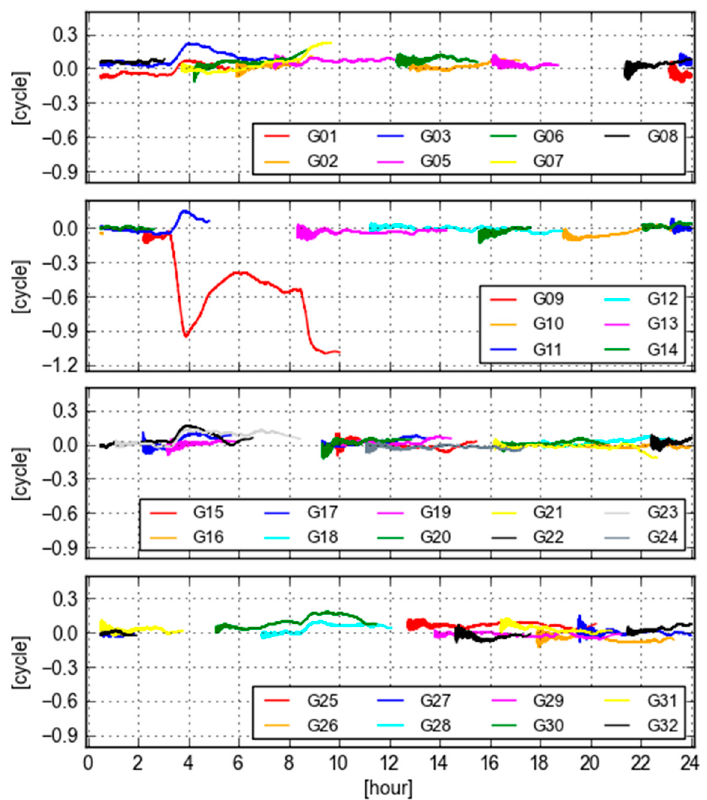
Figure 7. Differences of GB-GF WL ambiguities computed with real-time orbit and clock products at Site KOKV.